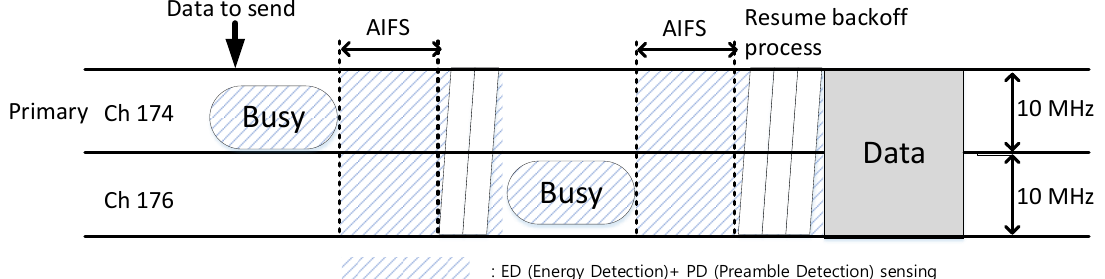
Figure 5. Proposed channel access scheme for 20-MHz transmission.